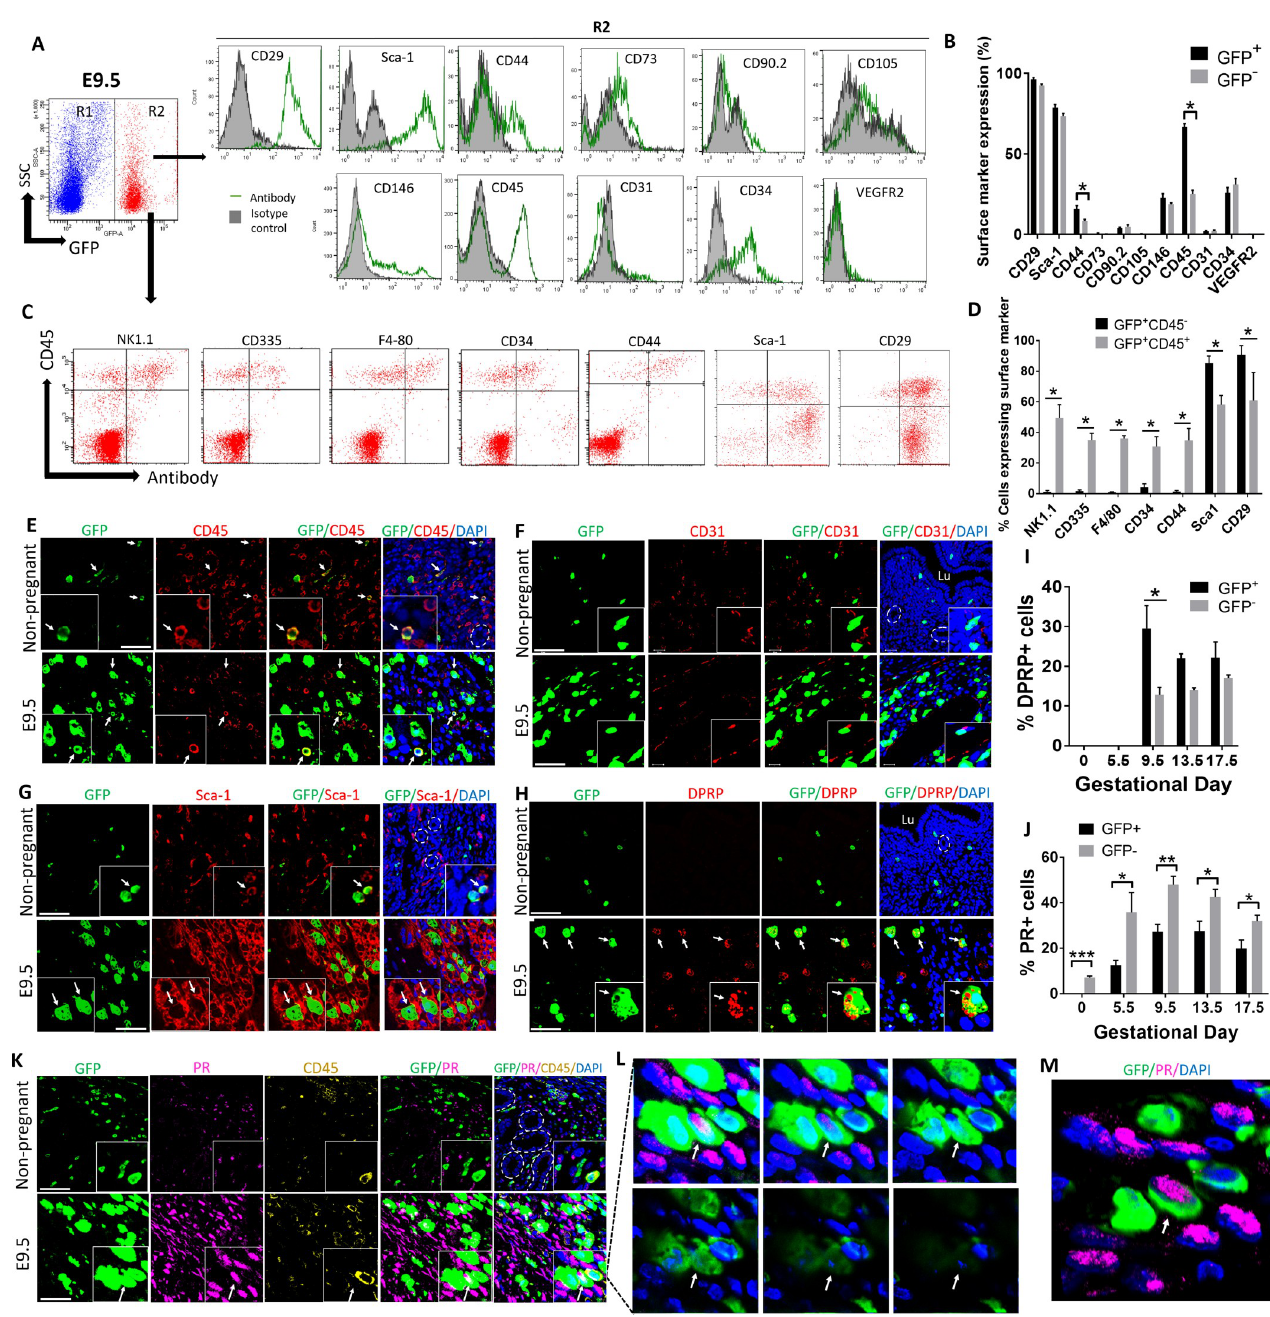
Fig 2. Characterization of uterine BMDCs throughout pregnancy. (A) Flow cytometry analysis of BMDCs in uterine implantation site on E9.5. Cells gated in R2 are BM derived (GFP + ) uterine cells, while cells gated in R1 are non–BM-derived resident (GFP − ) uterine cells. Histograms represent GFP + cells (R2) from E9.5 implantation sites that are stained with the indicated antibodies (green line) and respective isotype controls (filled) ( n = 4). (B) Quantification of percentage of BM-derived (GFP + ) and non–BM-derived (GFP − ) uterine cells expressing the various cell surface markers shown in (A) ( n = 4), � p < 0.05. (C) Flow cytometry analysis of E9.5 BM-derived (GFP + ) uterine cells (R2) using CD45 in combination with various surface marker antibodies. (D) Quantification of surface markers shown in (C), on BM-derived nonhematopoietic decidual cells (GFP + CD45 − ) and BM-derived hematopoietic cells (GFP + CD45 + ) ( n = 4–5), � p < 0.01. (E, F, G, H, K) Immunofluorescence photomicrographs of E9.5 mesometrial decidua sections or nonpregnant mice uteri sections demonstrating co- staining of GFP + BMDCs (green) with (E) CD45 (red), (F) CD31 (red), (G) Sca-1 (red), (H) DPRP (red), (K) progesterone receptor (PR) (pink), and CD45 (yellow). Sections were counterstained with DAPI showing nuclei (blue). Insets show higher magnification photomicrographs. White arrows point to BMDCs colocalizing with their respective markers. White dashes are encircling endometrial glands. Scale bars, 50 μ m. (L and M) A z-stack series (L) and a 3D image (M) of the inset from (K) demonstrating a single BM-derived GFP + cell co-expressing PR but negative for CD45 (white arrow). (I) Quantification of BMDCs